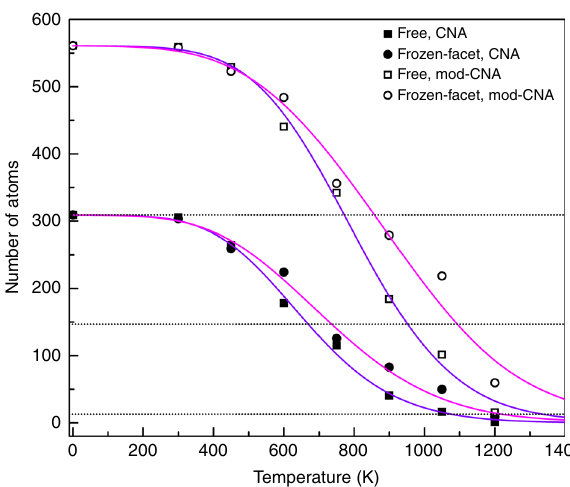
Fig. 5 Theoretical melting point suppression in cuboctahedral Au 561 nanoclusters. Scatter points represent statistical averages for the number of crystalline atoms obtained by the CNA (solid points) and modi fi ed CNA algorithms (hollow points) as a function of temperature for two families of simulations: nanoclusters all of whose atoms are free to move (squares), and nanoclusters having atoms of one (100) facet fi xed in place during the simulations (circles). The curves are sigmoidal fi ts to the data. Horizontal dotted lines denote the 309-, 147 and 13-atom limits